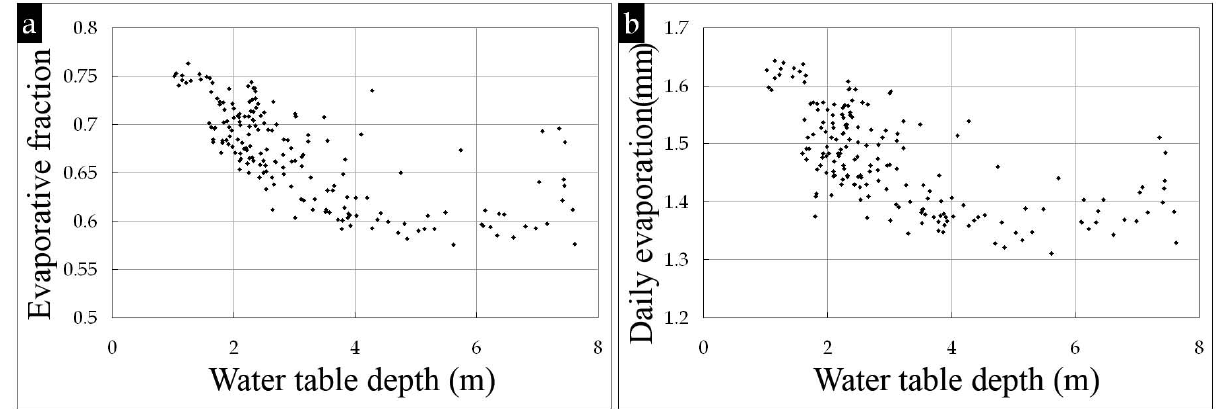
Fig. 11. The cross-relationships between the water table depth and both (a) the evaporative fraction and (b) the actual daily evaporation.